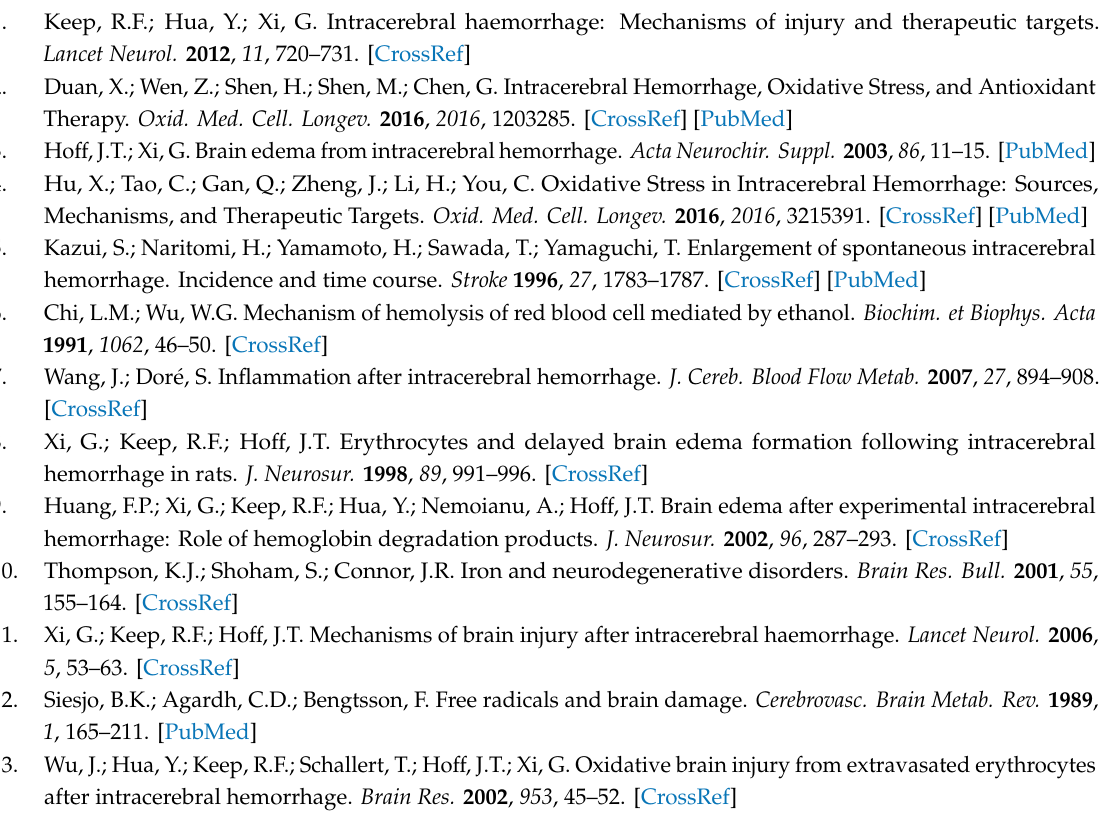
Figure S1: Oxidative stress (protein carbonyl content), and ubiquitin level expression in various ICH models. Oxidative stress level (protein carbonyl content, ( A ) and ubiquitinated (Ubiquitin level, B) in normal control (NC), ICH, I3: Three-fold collagenase injection volume (0.6 U in 3 microliter), and autologous blood infusion model (AB) at 3 h post-injury. Value are indicated by means ± SEM; n = 6 each group, * p < 0.05; ** p < 0.01; *** p < 0.001 as compared to normal group, respectively. Figure S2: Hematoma volume and GRP78 protein expression in various ICH models. Representative image of hemorrhagic brain sections ( A ) and statistical hematoma volume ( B ) in ICH, I3 and AB at 24 h post-ICH. Representative Western blotting images showing the GRP 78-kDa protein expression ( C ) and quantitative analyses of GRP78 protein ( D ) detected in the ipsilateral and contralateral striatum lysates at 3 h post-ICH injury. Value are indicated by means ± SEM; n = 6 each group, * p < 0.05; ** p < 0.01; and *** p < 0.001 as compared to the normal group, respectively. Figure S3: Co-localization of TUNEL and Ubiquitin protein in perihematomal and core hemorrhagic striatal region at 1 day post-ICH. The yellow arrow in the merged figure indicates the co-localization of TUNEL-positive and ubiquitin-positive cells expression. The white arrow in the merged figure indicates no co-localization of TUNEL-positive and ubiquitin-positive cells